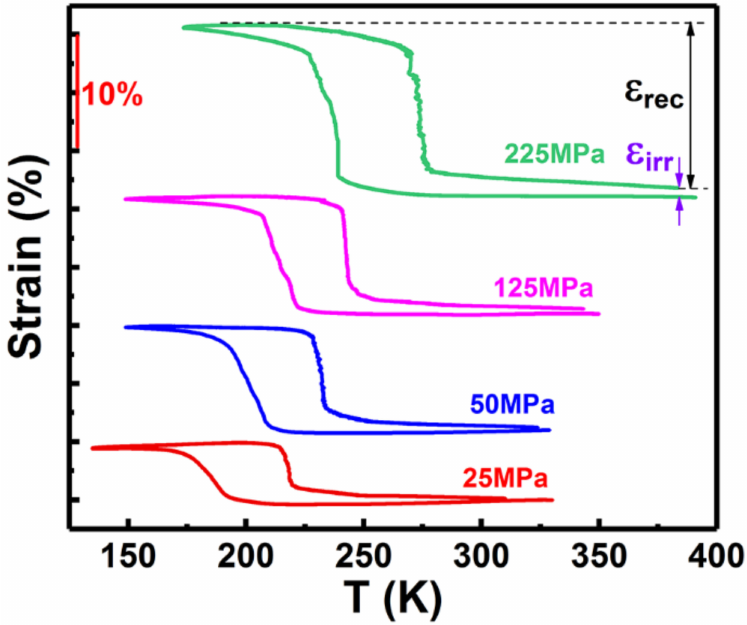
Figure 4. Strain–temperature curves measured under different constant stresses for the Ni 50 Mn 34 Fe 3 In 13